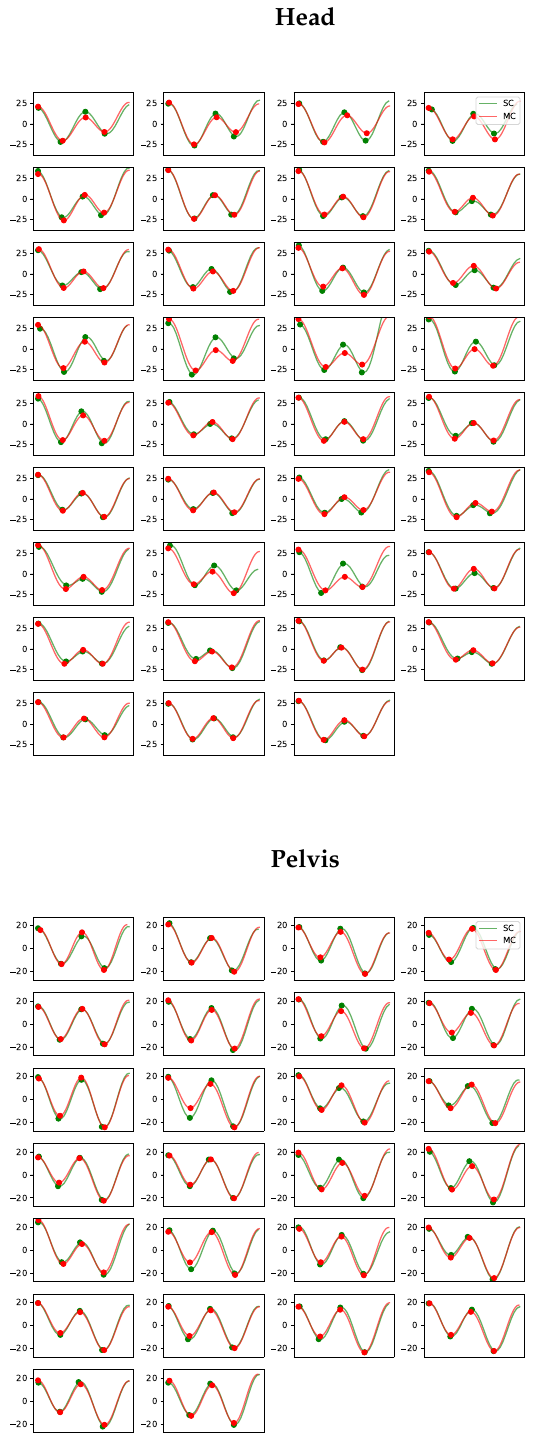
Figure A18. Vertical displacement signals per stride for the head and pelvis for horse 19. Each subplot contains the matched stride segments for the single-camera markerless system (SC) in green and the multi-camera marker-based system (MC) in red. The y-axis shows the vertical displacement in millimeters. The four dots on each curve indicate the positions of the two peaks and two valleys extracted using the approach in Section